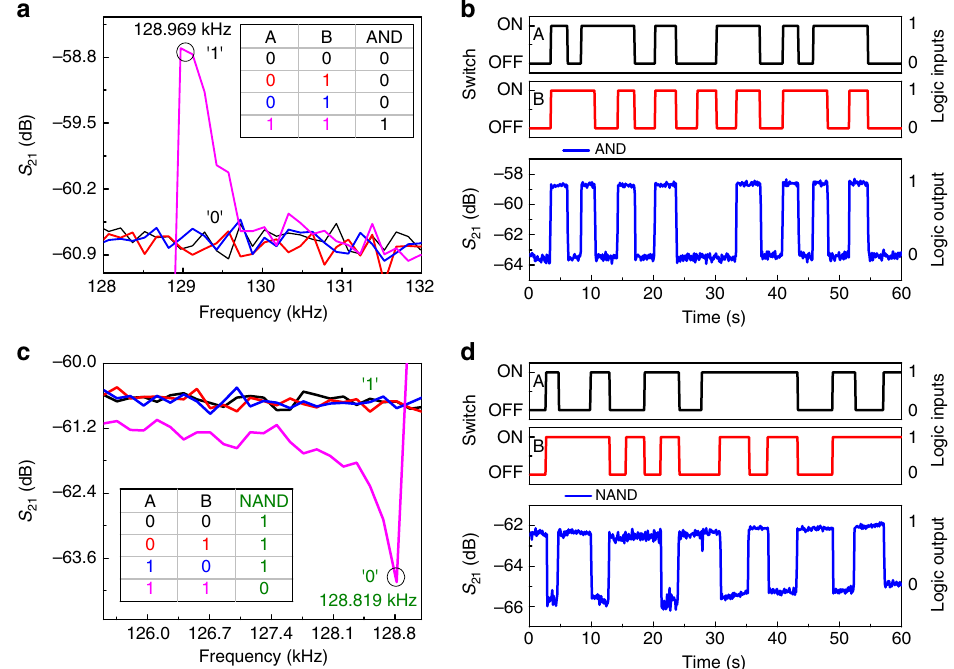
Figure 7 | Demonstration of 2-bit AND and NAND logic gates. ( a ) Frequency responses of the resonator for different logic input conditions, where (1,1) logic input condition shown in magenta has high S 21 transmission signal at 128.969kHz and others have low signal represented by 1 and 0, respectively. Truth table of AND logic output is shown in the inset. ( b ) Demonstration of AND logic operation when the operation of frequency is chosen as 128.969kHz. Two input signals, A and B are shown in black and red, respectively, where the switch OFF/ON corresponds to 0/1 logic input conditions. S 2 1 transmission signal in blue corresponds to the logic output and fulfills the AND truth table. ( c ) Frequency responses of the resonator for different logic input conditions, where (1,1) logic input condition has low S 21 transmission signal at 128.819kHz and others have high S 21 transmission signal represented by 0 and 1, respectively. Truth table of NAND logic output is shown in the inset. ( d ) Demonstration of NAND logic operation when the operation of frequency is chosen as 128.819kHz. Two input signals, A and B are shown in black and red, respectively, where the switch OFF/ON corresponds to 0/1 logic input conditions. S 21 transmission signal in blue corresponds to the logic output and fulfills the NAND truth